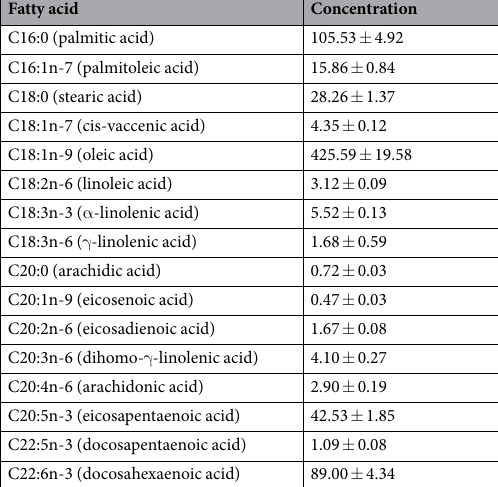
Table 2. Fatty acid concentrations in the fish oil supplement (mg/g of oil), determined by gas chromatography. Data are means ± standard deviations, from analysis of 6